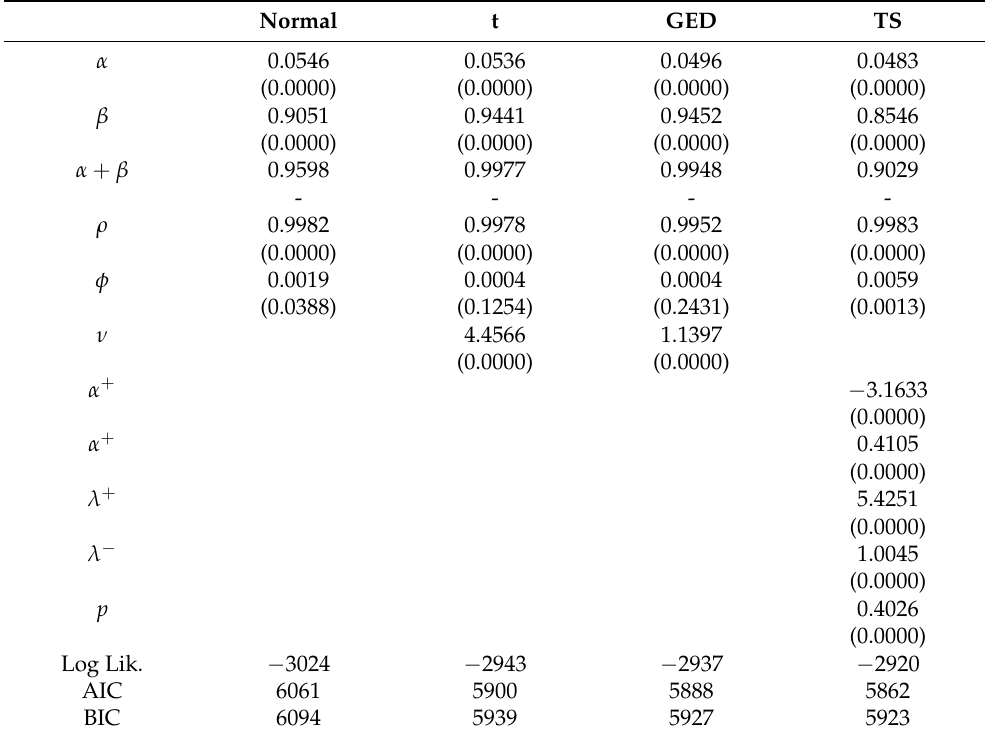
Table 4. Empirical results: SSE